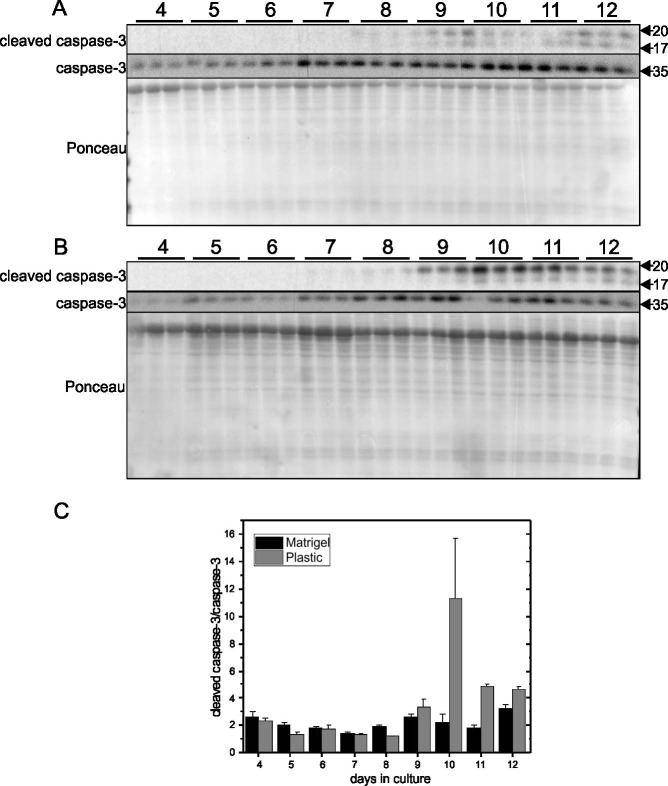
Time course of cleaved caspase-3 and caspase-3 in EA.hy926 cells grown on Matrigel-coated or plastic culture plates.EA.hy926 endothelial cells were seeded on plastic plates at 9000 cells/cm2 and grown for 12 days. Protein levels of cleaved caspase-3 and caspase-3 were determined by Western blotting of cell lysates prepared each day from day 4 to day 12. Representative blots are shown in Panel A (Matrigel) and B (Plastic). Densitometry was used to quantify the intensity of the bands in Panel A and B, and data were normalized to a band visualized by Ponceau staining (Panel C). Data are presented as means ± SEM (n = 3).